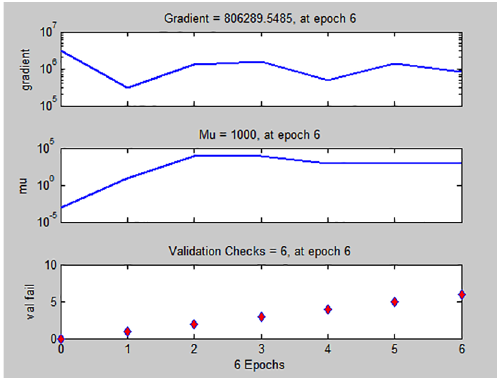
Figure 15. Training state